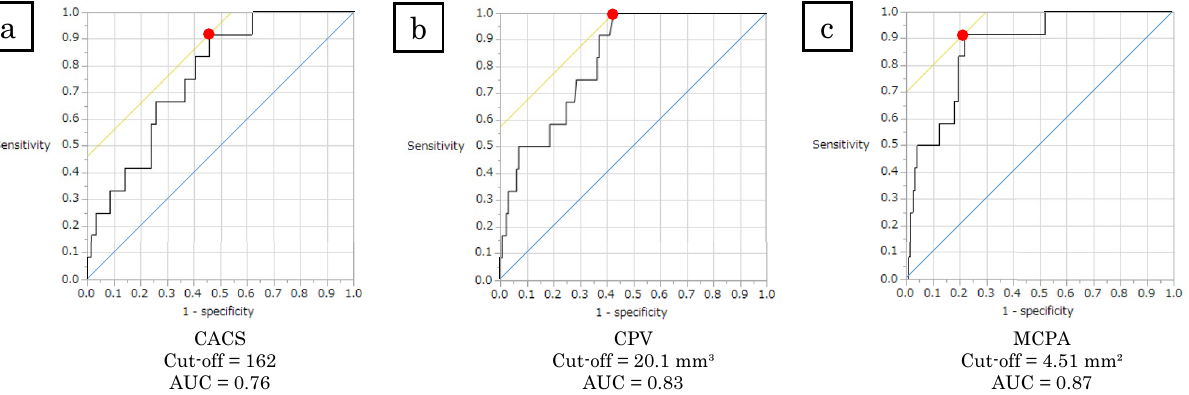
Figure 3. ROC curve analysis for CCTA findings to predict CN; CACS ( a ), CPV ( b ), MCPA ( c ). The optimal cutoffs to predict CNs are CACS ≥ 162 (AUC = 0.76), CPV ≥ 20.1 mm 3 (AUC = 0.83), and MCPA ≥ 4.51 mm 2 (AUC = 0.87). AUC area under the curve, CACS coronary artery calcification score, CCTA coronary computed tomography angiography, CN calcified nodule, CPV calcified plaque volume, MCPA maximum calcified plaque area on cross-sectional image, ROC receiver operating characteristic curve.